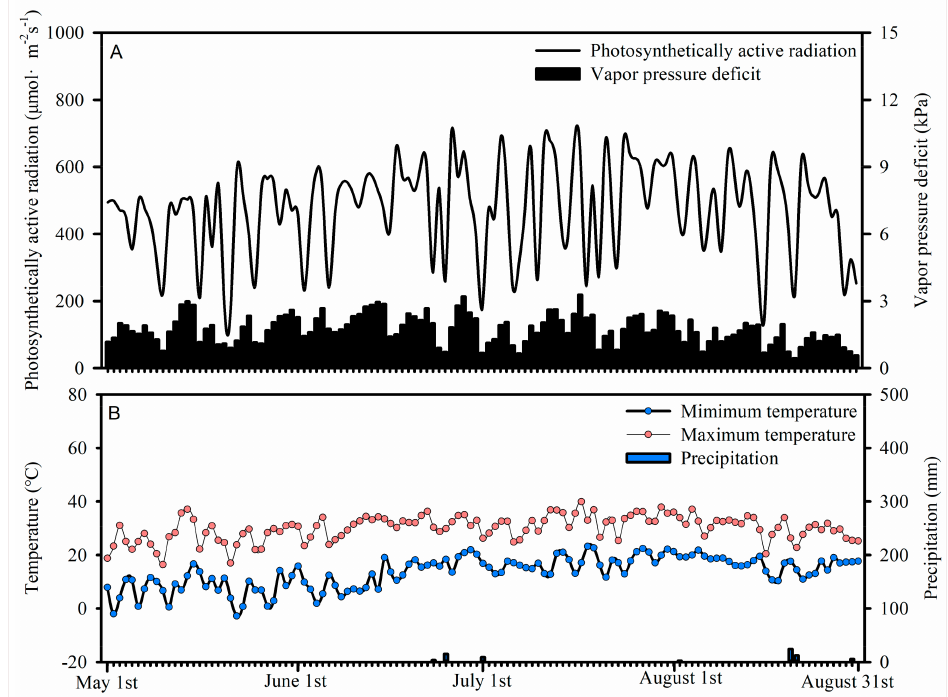
Figure 1. Daily photosynthetically active radiation ( A ), vapor pressure deficit ( A ), temperature ( B ), and precipitation ( B ) in Drylands Salinization Research Station during the experiment in